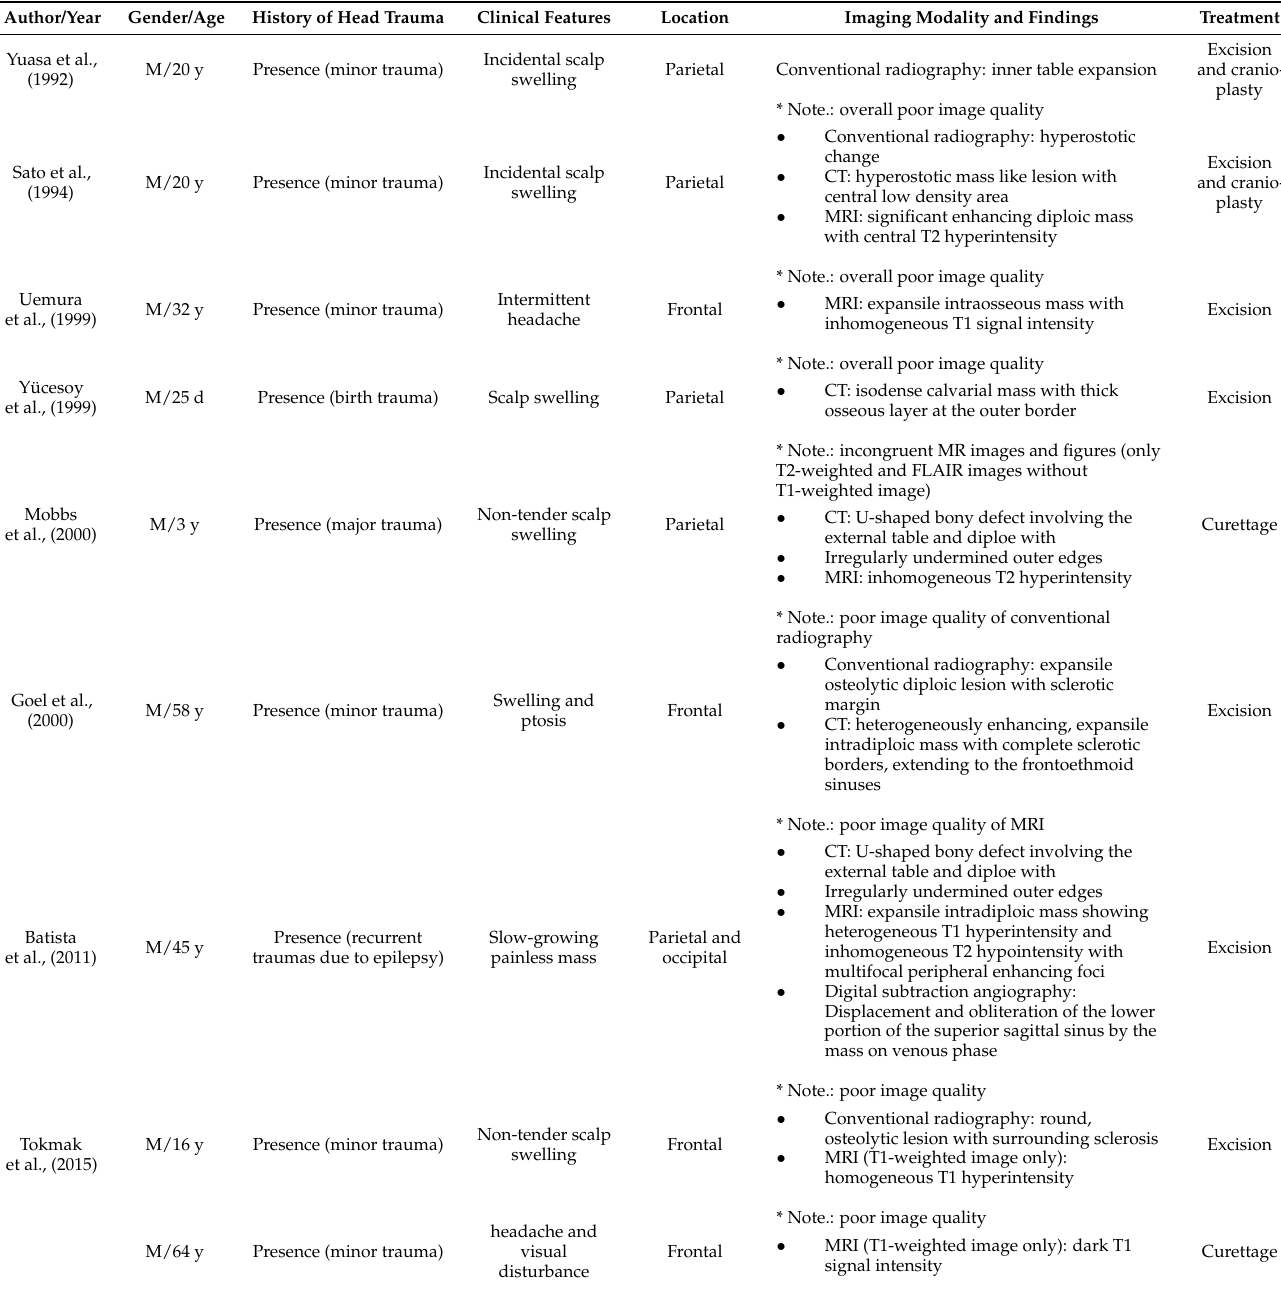
Table 1. Reported chronic intradiploic organizing hematoma cases in the skull vault based on histopathological diagnosis in the literature †